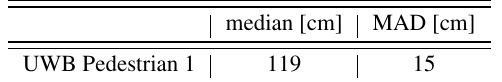
Table 2. 2D positioning results obtained with UWB when the LiDAR view of the pedestrian was occluded.